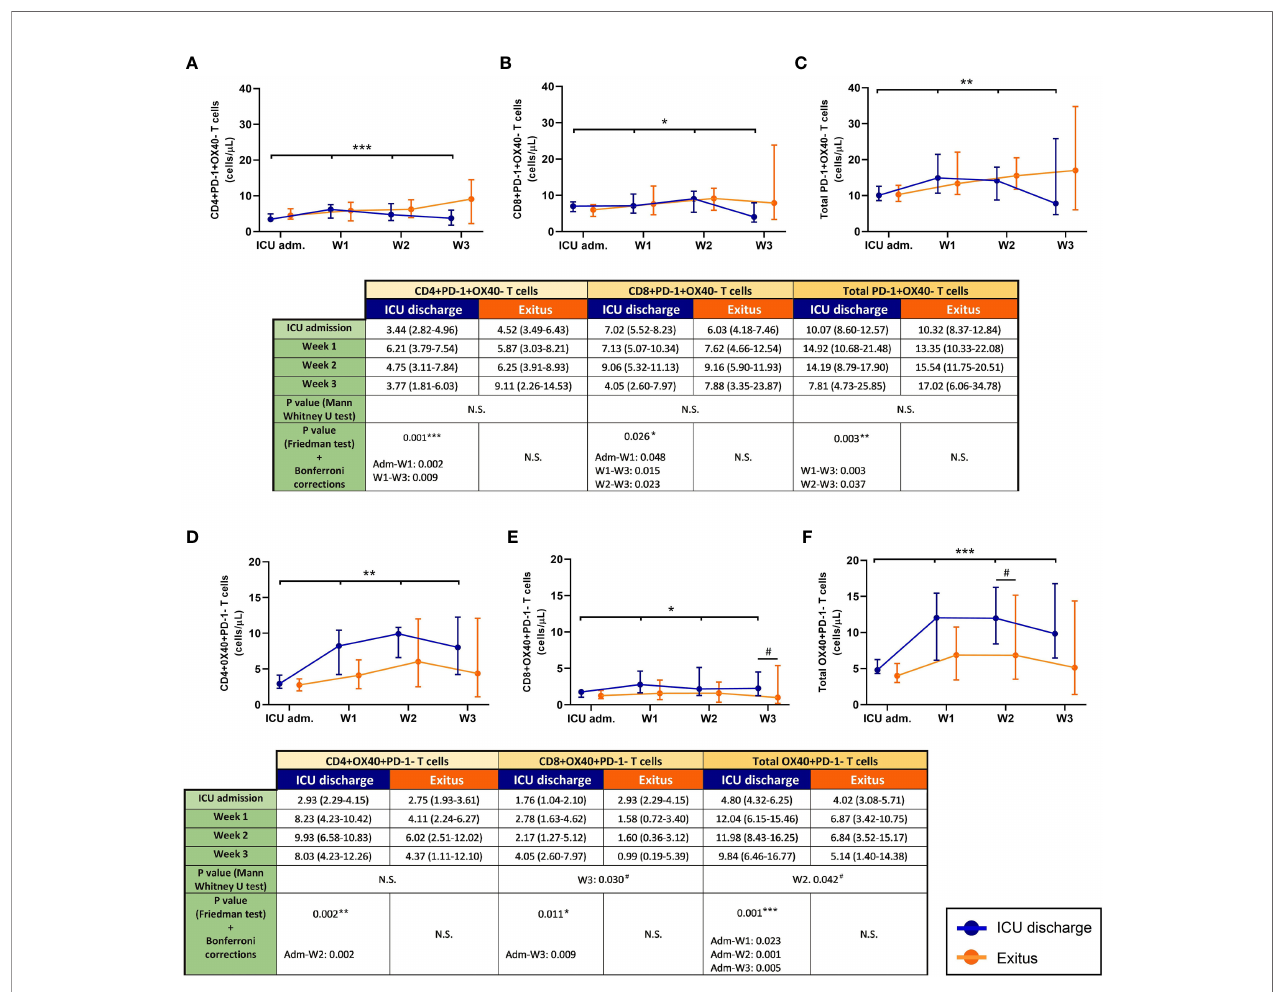
FIGURE 3 | Circulating exhausted (PD-1 + OX40 − ) and activated (OX40 + PD-1 − ) T cells in discharged ( blue ) and deceased ( red ) coronavirus disease 2019 (COVID-19) patients during their follow-up in the ICU. (A) CD4 + PD-1 + OX40 − T cells. (B) CD8 + PD-1 + OX40 − T cells. (C) Total PD-1 + OX40 − T cells. (D) CD4 + OX40 + PD-1 − T